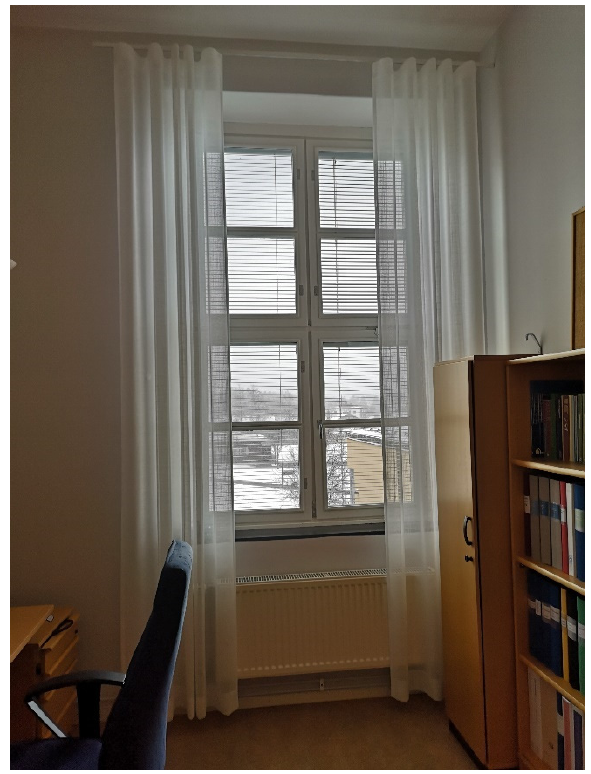
Figure 7. The window configuration in Room A.